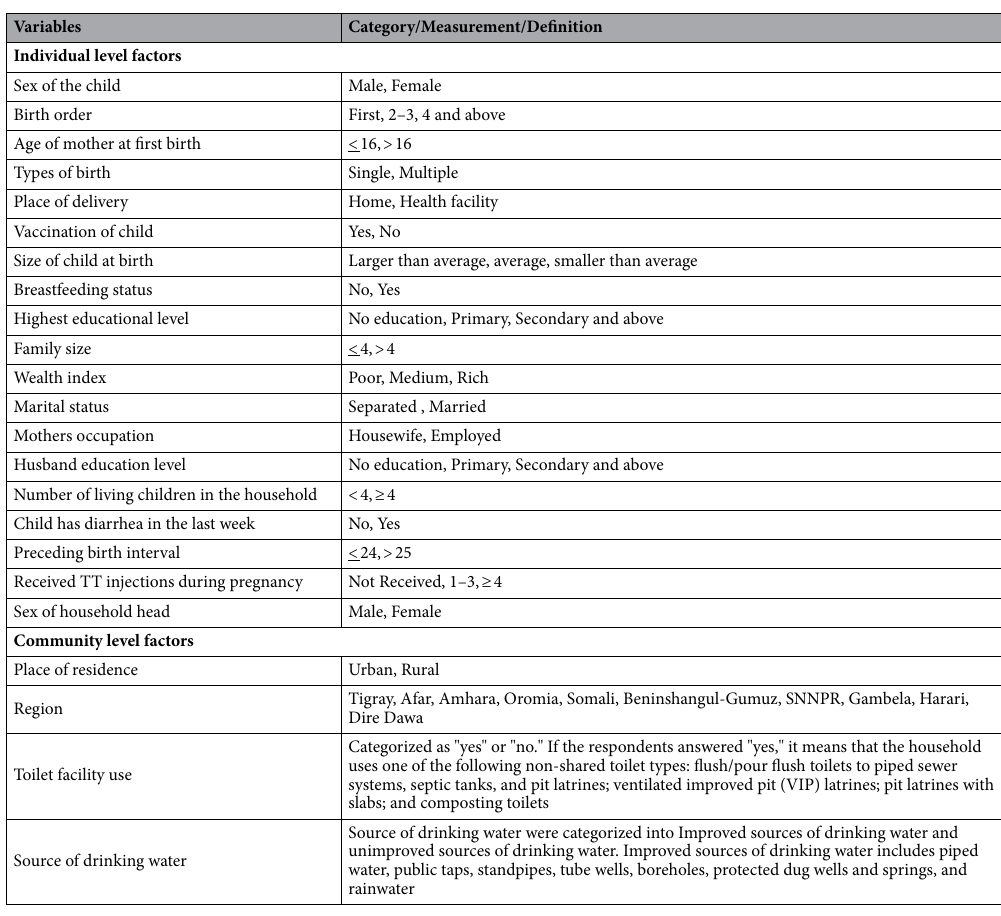
Data management and analysis. The variables were extracted from the BR dataset using SPSS software version 21, and then exported to the statistical software R version 3.5.3 for further analysis. Data were weighted after extraction using sampling weight (v005), main sampling unit (v023), and strata (v021) to account for unequal probability of selection and non-response. Descriptive analysis was done and sample characteristics were pre- sented in frequency and percentages to show the distribution of respondents by the selected variables. The data in EDHS were not flat and were collected using multistage stratified cluster sampling techniques. To draw valid inferences and conclusions, advanced statistical models such as hierarchical modelling, which consider inde- pendent variables measured at the individual and community levels, should be used to account for the clustering effect/dependency. A two-level multilevel logistic regression analysis was used to examine the effects of individ- ual- and community-level characteristics on infant death and to determine the extent to which characteristics at the individual and community levels explain enumeration area variations in infant death in rural Ethiopia. The reason for using multilevel logistic regression model was to account for the hierarchical (correlated) structure of the data. The assumption is that infant and their households are nested within enumeration area (communities). This suggests that infant in households with similar characteristics can have different health outcomes when residing in different communities with different characteristics. The log of the probability of infant death was modeled using a two-level multilevel model as follows: Log (cid:31) where, i and j are the level 1 (individual) and level 2 (community) units, respectively; X and Z refer to individual and community-level variables, respectively; π ij is the probability of infant death for the ith women in the j th community; the β indicates the fixed coefficients. Whereas, β 0 is the intercept-the effect on the probability of infant death in the absence of influence of predictors; and u j showed the random effect (effect of the community on infant death for the j th community and e ij showed random errors at the individual levels. By assuming each community had different intercept ( β 0 ) and fixed coefficient ( β ), the hierarchical (clustered) data nature and the within and between community variations were taken into account. Four models were fitted to identify com- munity and individual level factors associated with infant death. The first model (Model 1 or empty model)